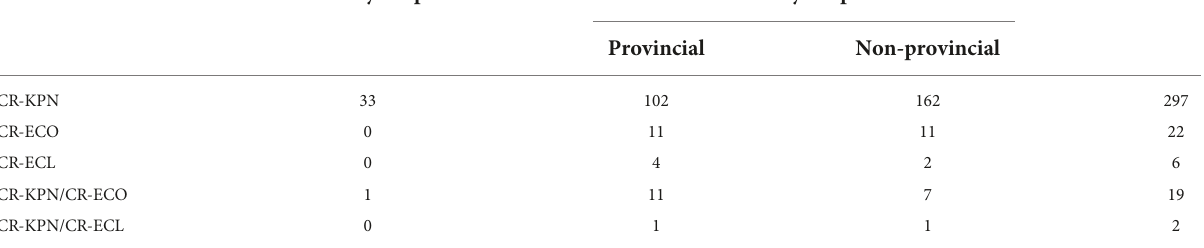
TABLE 3 Strains detected in different level hospitals.